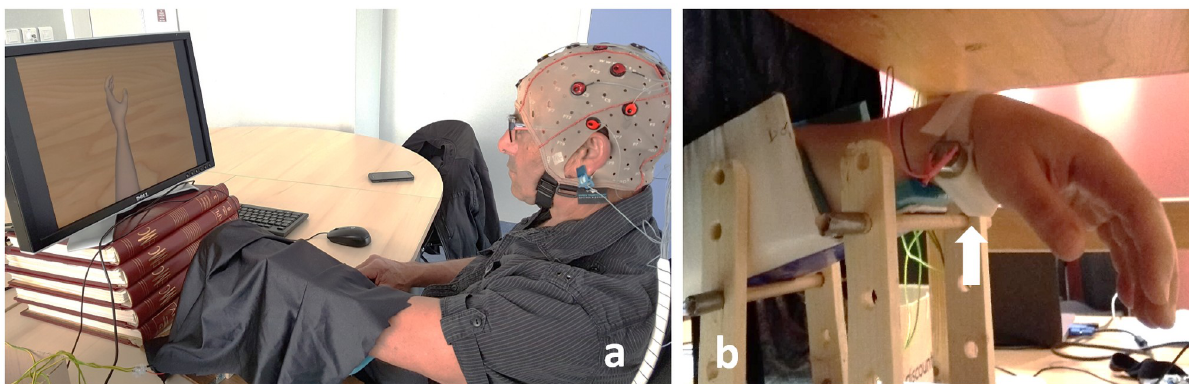
Fig 1. Apparatus used in the experiment. a) Positioning of the participant during EEG recording. The vibrator was positioned on the left, non- dominant wrist, hidden from view by the participant with a black cloth. b) Set-up of the vibrator on the flexor carpi tendon. The forearm was positioned in a shell. The white arrow indicates the